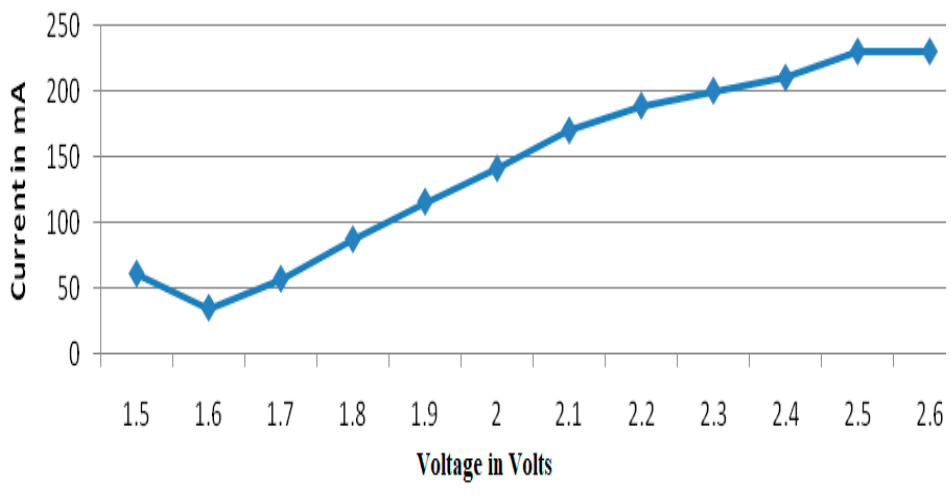
Figure 11. ( a ) Schematic diagram of charging mode of the modified unitized regenerative fuel cell (URFC) or proton battery; ( b ) schematic diagram of discharging mode of modified URFC or proton battery.